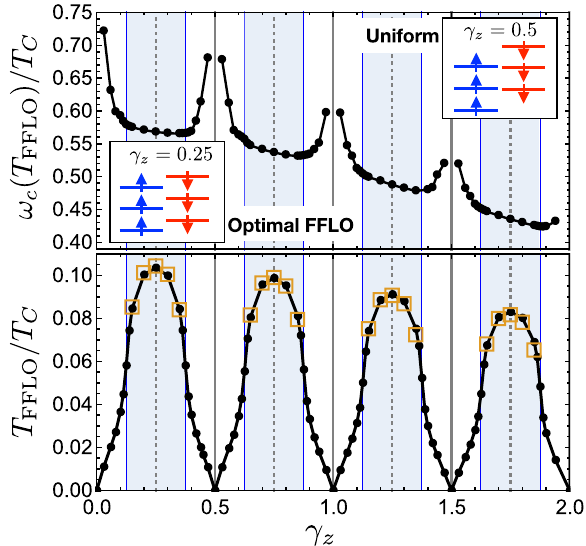
FIG. 5. The lower panel shows the dependence of the FFLO onset temperature T on the spin-splitting factor γ . The z FFLO 10 . In contrast = μ ¼ 0 . 2 and μ =T parameters in this plot are t z C ¼ to the quasiclassical case, the FFLO states emerge at finite T FFLO γ even when the γ is very small. Furthermore, T oscillates z z Þ FFLO ð n þ 1 = 2 corresponding to the and its maxima are located at 2 γ z ¼ largest minimum separation between the opposite-spin Landau 0 . 25 . Open squares show levels, as illustrated in the inset for γ z ¼ analytical estimates using Eq. (19). The upper panel shows the γ z dependence of the cyclotron frequency at the upper critical field for T ¼ T . We omit the points at the resonances FFLO 1 ; 2 ; … ), where the spin degeneracy of the Landau levels ( 2 γ z ¼ 0 . 5 . The FFLO transition is absent at is restored; see inset for γ z ¼ these